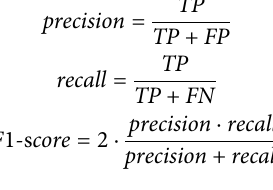
Use in speci fi c populations